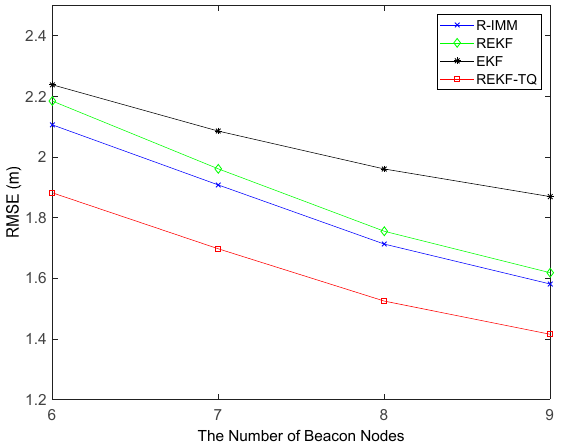
Figure 14. The RMSE versus the number of beacon nodes. Table 4. The mean value of error, standard deviation of error, root mean squared error (in m) of estimators for Gaussian, exponential and uniform NLOS Distributions.